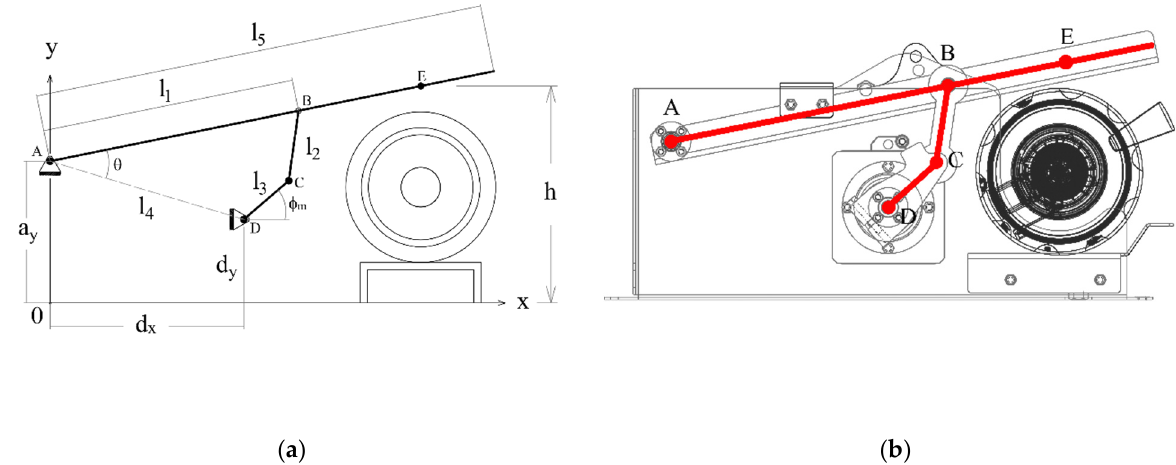
Figure 5. ( a ) Conceptual diagram of the mechanism, ( b ) geometry of the detail design with the diagram superimposed.